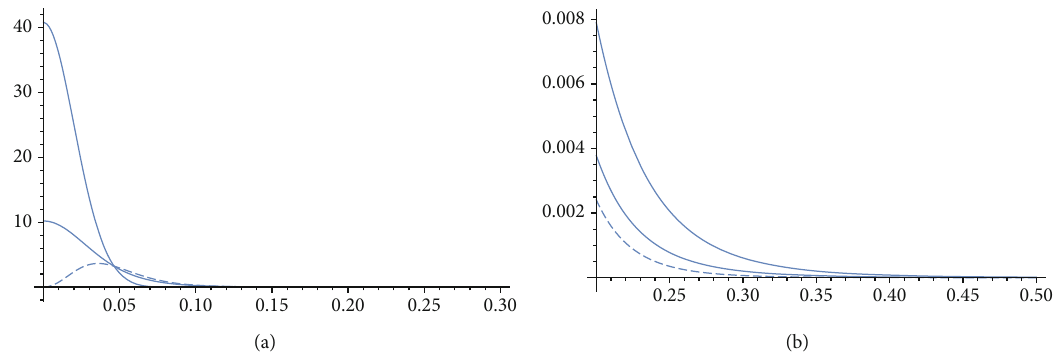
Figure 8: (a) We exhibit the dependence of the form factors encountered in the ionization of Na as a function of the momentum transfer, in units of the electron mass. (b) The same fi gure restricted to higher momentum transfers. The here momentum of the emitted electron p e solid line corresponds to n = 1 , the thick solid line to n = 2, ℓ = 0 , and the dashed line to n = 2, ℓ = 1